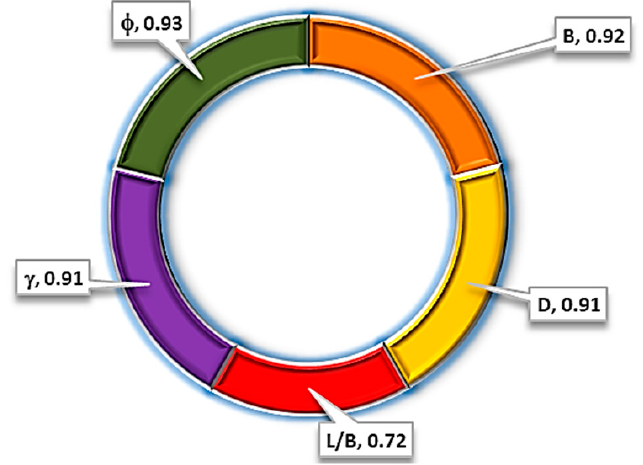
Figure 4. Sensitivity analysis using a pie chart.